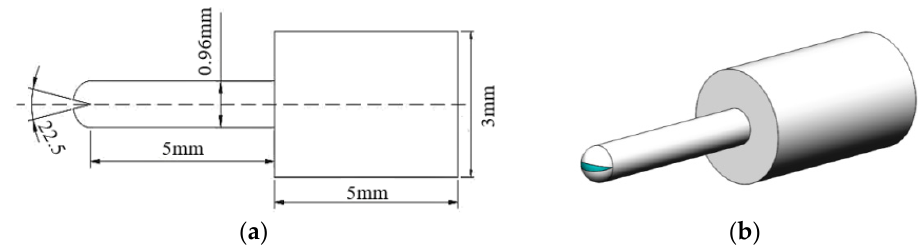
Figure 7. Inner cavity model size of 0.48 mm equivalent diameter nozzle: ( a ) 0.48 mm equivalent nozzle internal cavity model size; ( b ) 0.48 mm equivalent nozzle internal cavity geometry model.